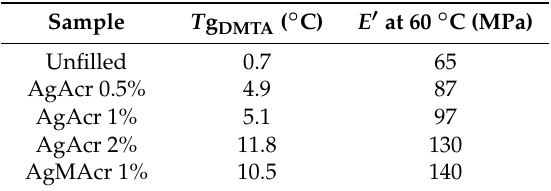
Table 2. Glass transition temperature ( T g DMTA , evaluated as temperature value corresponding to tan δ peak) and storage modulus at 60 °C values for all the printed specimens, from Dynamic-mechanical thermal analysis (DMTA) analyses.